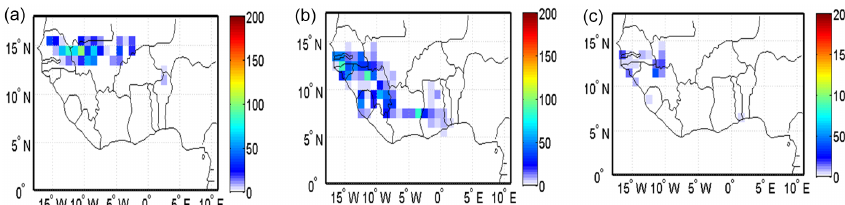
Figure 5. Mean spatial distribution of early fires that occurred in (a) October and late fires that appeared in (b) March and (c) April between 2000 and 2007.